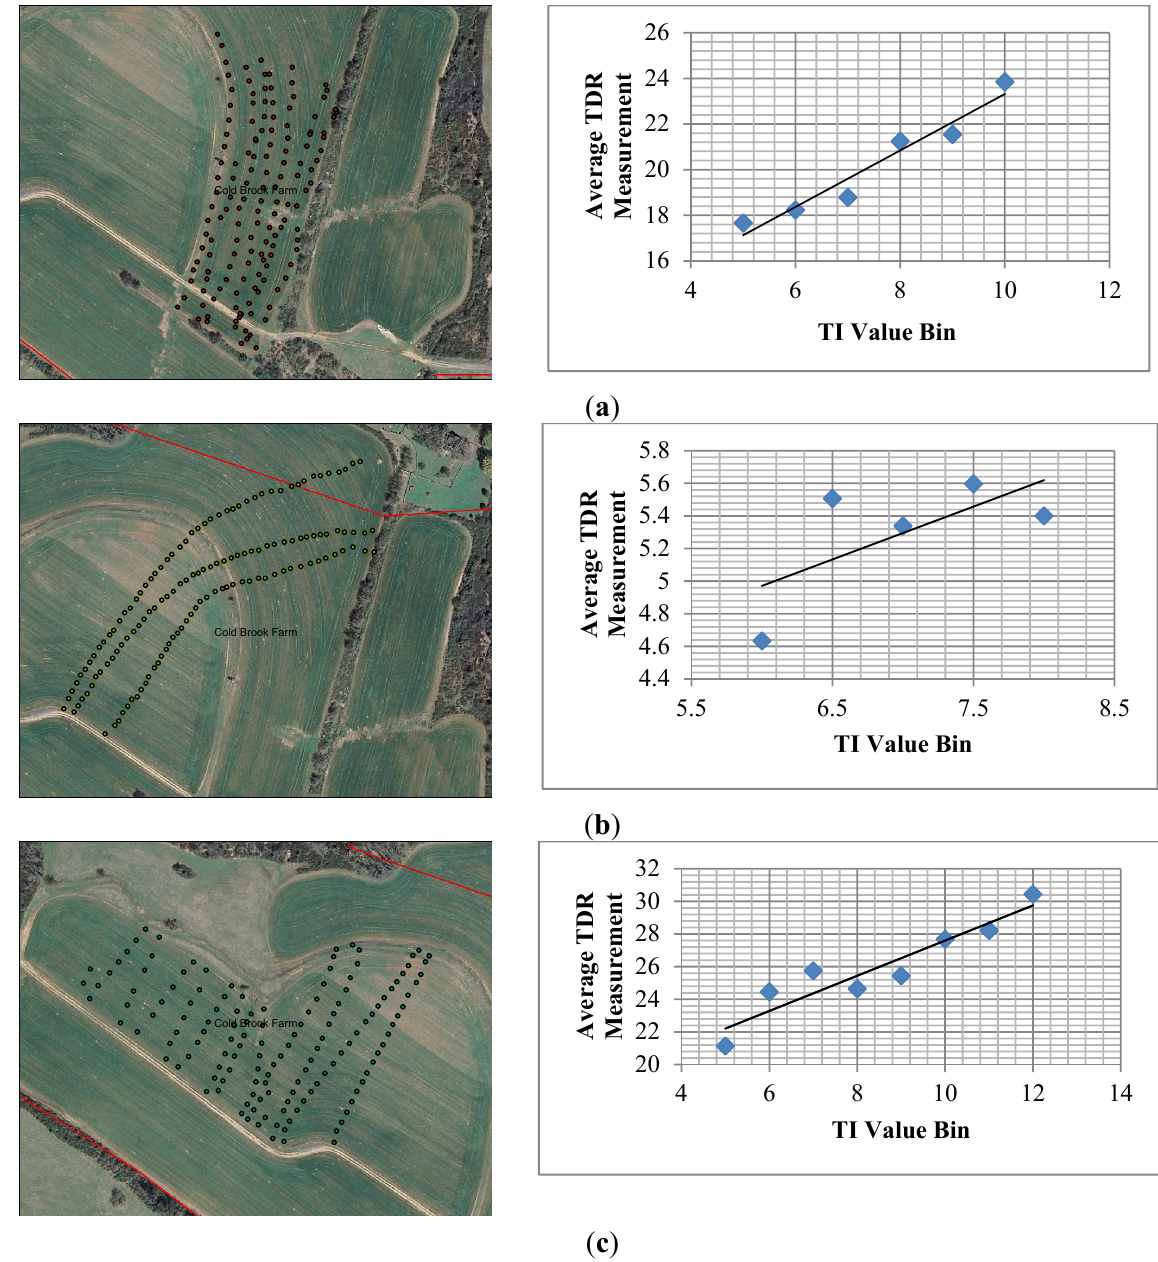
Figure 3. Comparison between TI Values and TDR Measurement (%) at Cold Brook Farm. ( a ) On 8 June 2009 (TDR = 1.2373TI + 10.942; R 2 = 0.9402); ( b ) On 1 December 2009 (TDR = 0.3246TI + 3.0231; R 2 = 0.4489); ( c ) On 30 April 2010 (TDR = 1.0783TI + 16.813; R 2 =